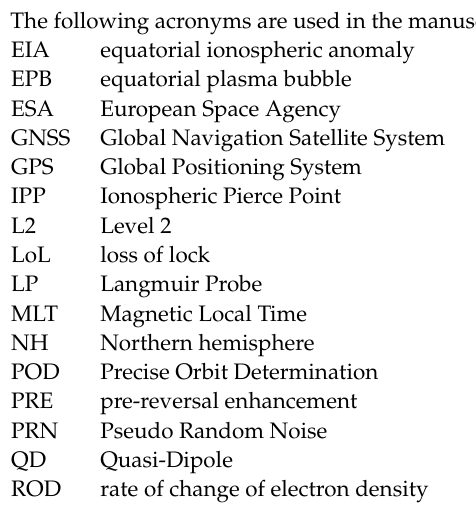
but for Figure 5, Figure S3: Same as Figure 8 but for Figure 4, Figure S4: Same as Figure 8 but for Figure 5, Figure S5: RODI version of Figure 6, Figure S6: ROTI version of Figure